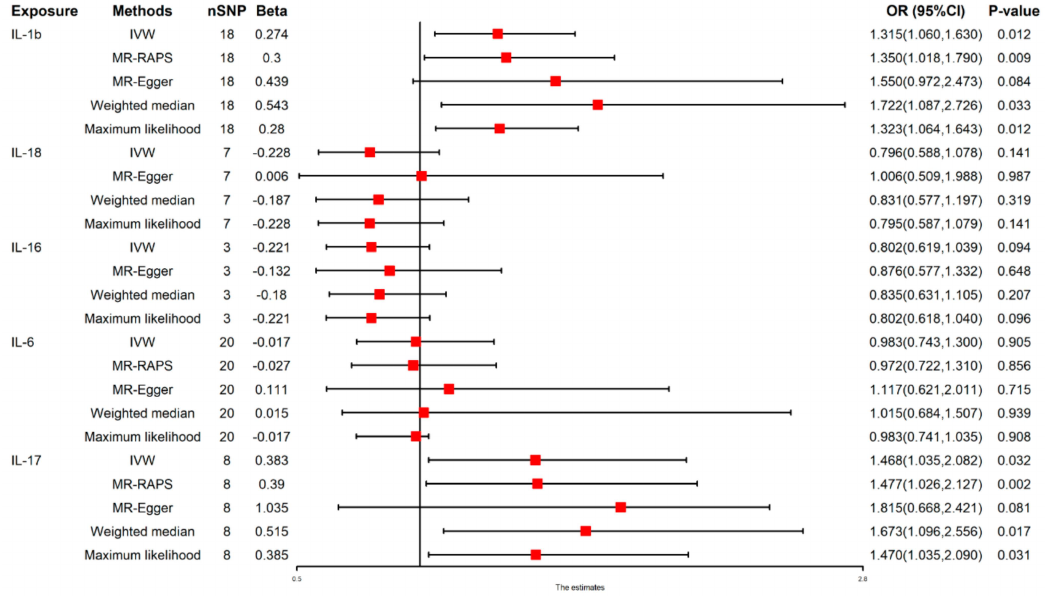
Figure 2. Causal effect of flammatory factor on NAFLD. The red point means the effect